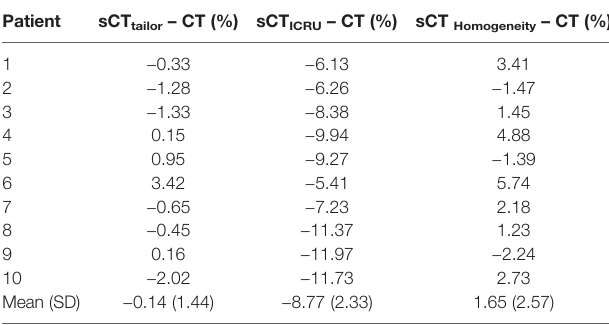
TABLE 4 | Point dose comparison for different sCT based plans.